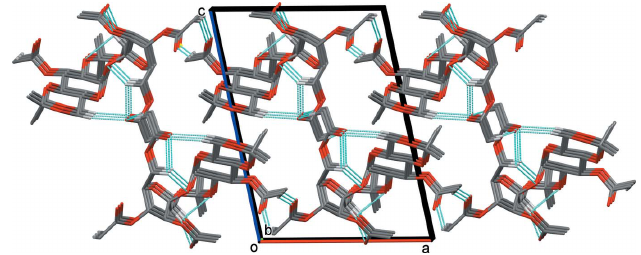
Figure 2 A view along the b axis of the crystal packing of the title compound. The hydrogen bonds (Table 1) are shown as dashed lines. For clarity, only the H atoms involved in the intra- and intermolecular hydrogen bonds have been included.